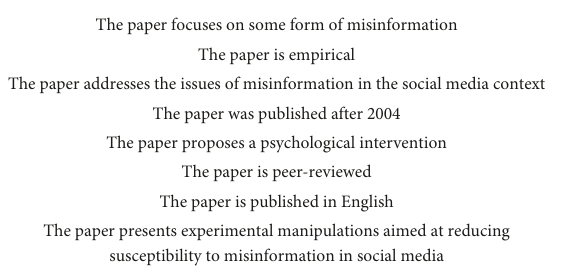
TABLE 2 Inclusion criteria for scoping